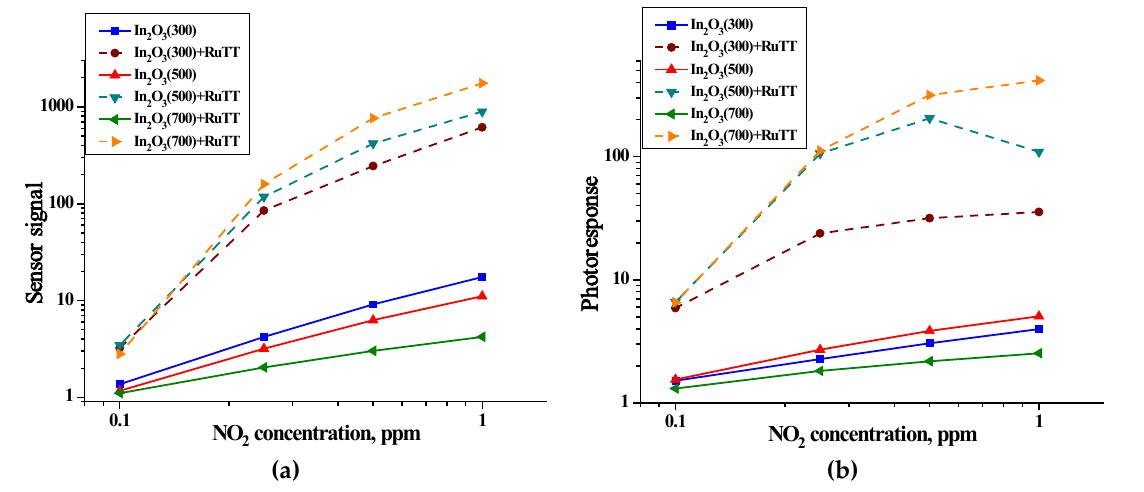
Figure 9. Dependence of the sensor signal ( a ) and photoresponse ( b ) of In 2 O 3 (300), In 2 O 3 (500), In 2 O 3 (700) samples and hybrid materials based on them on the concentration of NO 2 .